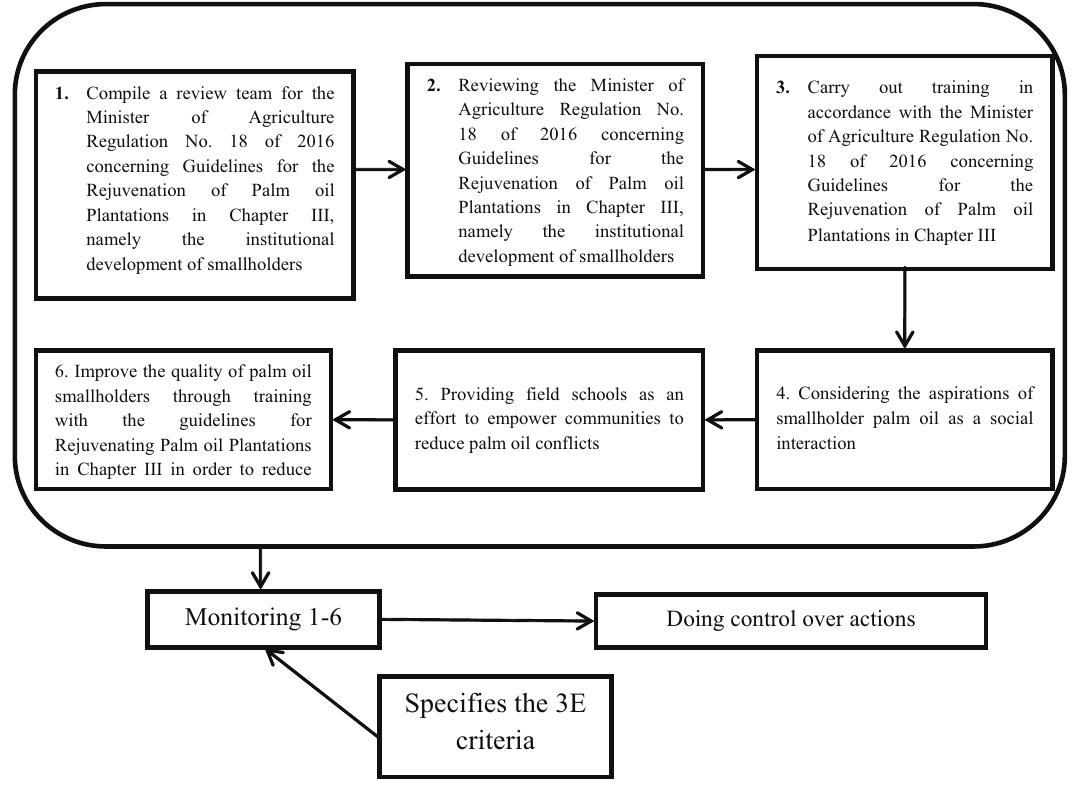
Figure 5: Conceptual model based on RD